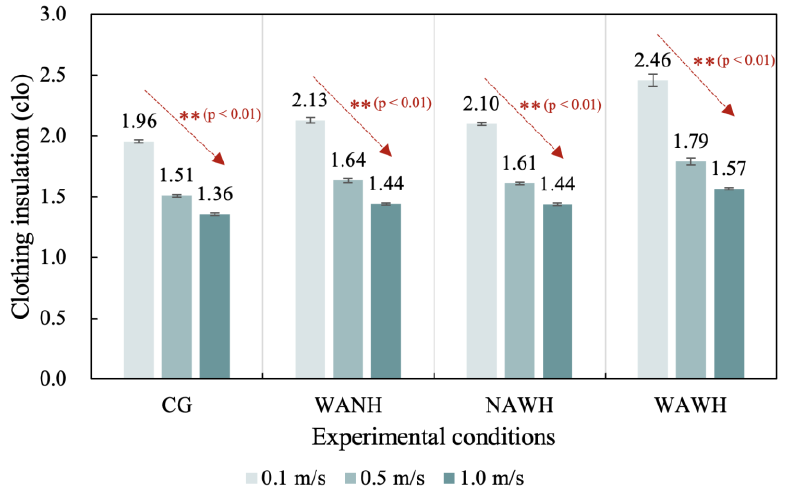
Figure 8. I t of four garments at different V a